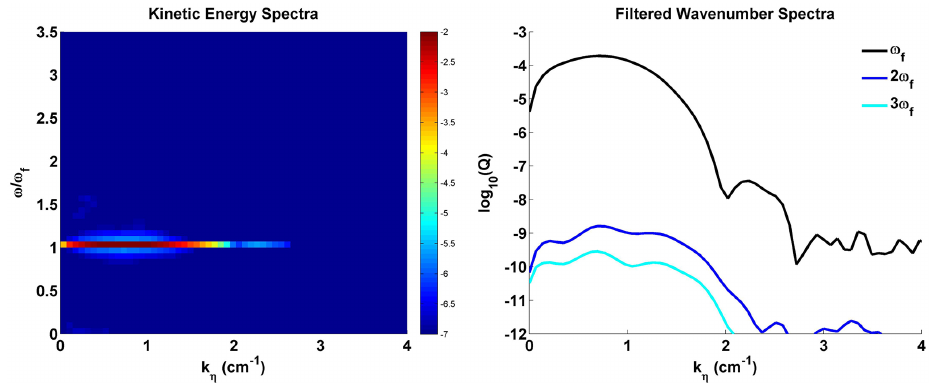
Figure 3. An example incident internal wave beam 2-D kinetic energy (log scale) spectrum (left), which is strongly peaked at the forcing frequency, and the spectrum filtered for primary and harmonic frequencies (right). Results from the simulation with θ = 40 ◦ and r = 4.